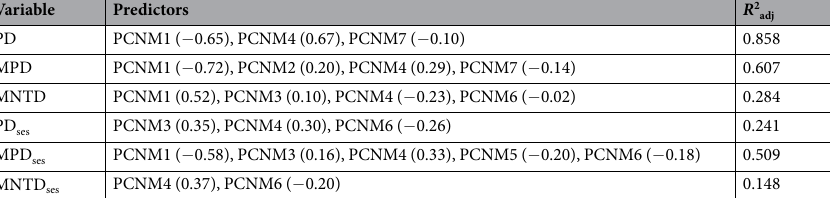
Table 3. Spatial variables retained in best-fit models and standardized regression coefficients (in parentheses). All models are significant ( P < 0.05).